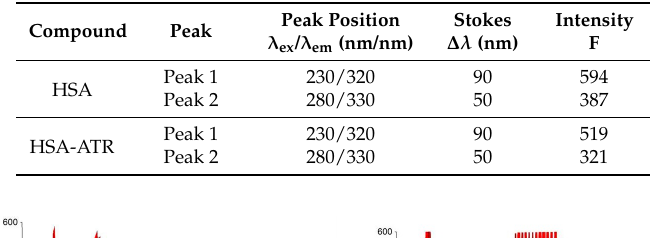
Table 6. Intensity ratios of peaks 1 and 2.